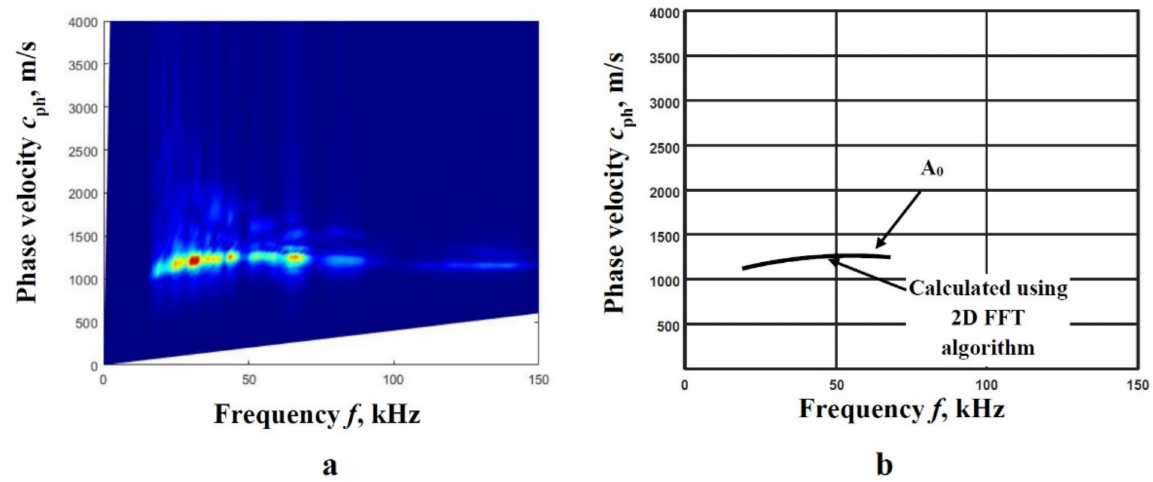
Figure 13. The 2D-FFT spectra (colour) ( a ), the reconstructed phase velocities of the A 0 mode calculating the peak values of spectrum magnitude from 2D-FFT ( b